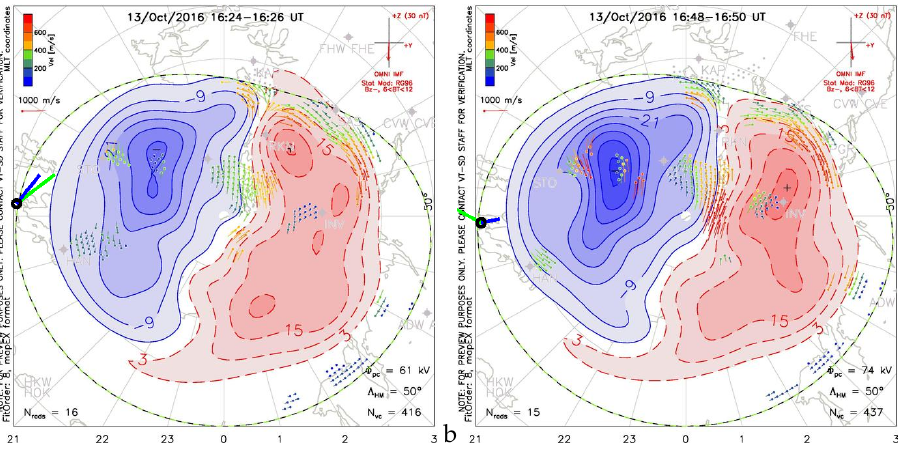
Figure 16. Qualitative caption. comparison of drift estimation by two methods, according to for- mula (12)—green—and formula (20)—blue—with ionospheric convection obtained by the Super- DARN system for moments: marked in Figure 19a,b with green vertical lines, for the quiet time (set L552177); panel ( a ) for 16:24 UT, and panel ( b ) for 16:48 UT of